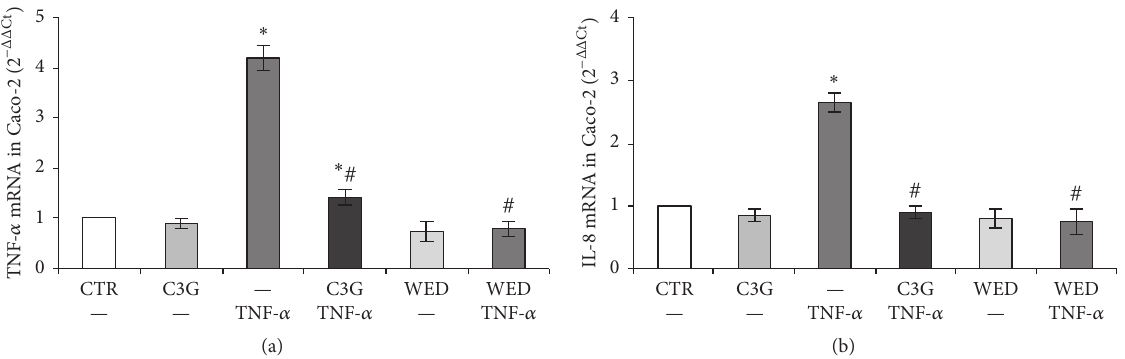
Figure 3: (a) TNF- 𝛼 and (b) IL-8 gene expression in Caco-2 cells. The Caco-2 cell monolayer was pretreated for 24 hours with 20 𝜇 M C3G or with 25 𝜇 M WED for one hour and subsequently exposed to 50 ng/mL TNF- 𝛼 for one hour. Cultures treated with the vehicle alone (0.1% DMSO) were used as controls (CTR). Results, deriving from three independent experiments, are expressed as 2 −ΔΔ Ct (mean ± SD). 18S rRNA was used as housekeeping gene. ∗ 𝑝 < 0.05 versus CTR; # 𝑝 < 0.05 versus TNF- 𝛼 .